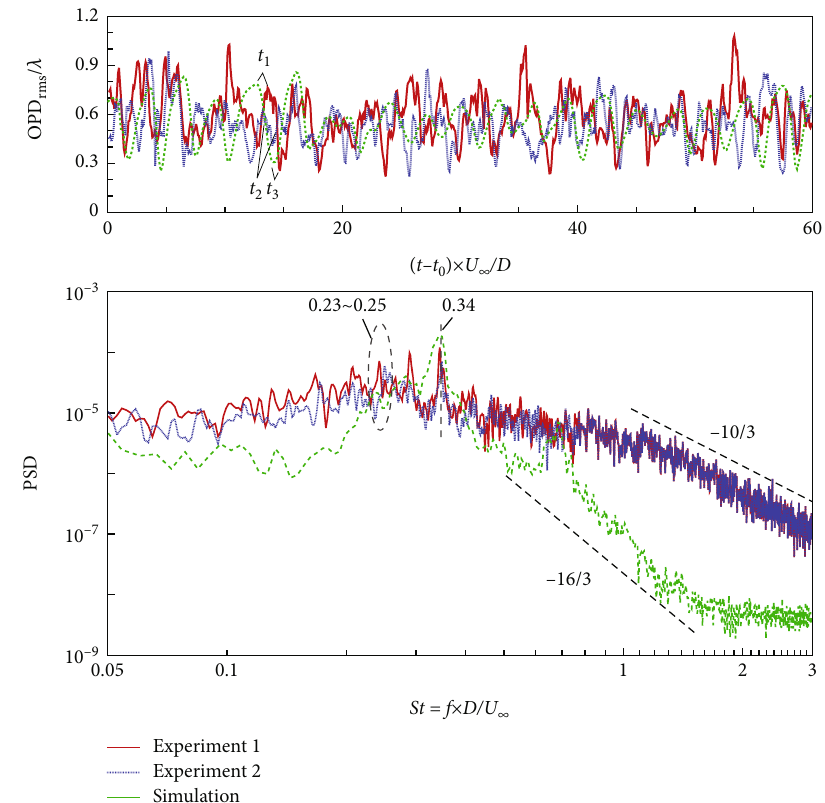
Figure 15: The root-mean-square of transient wavefront ð OPD and dotted blue line represent two experiments, and the green dotted line represents the